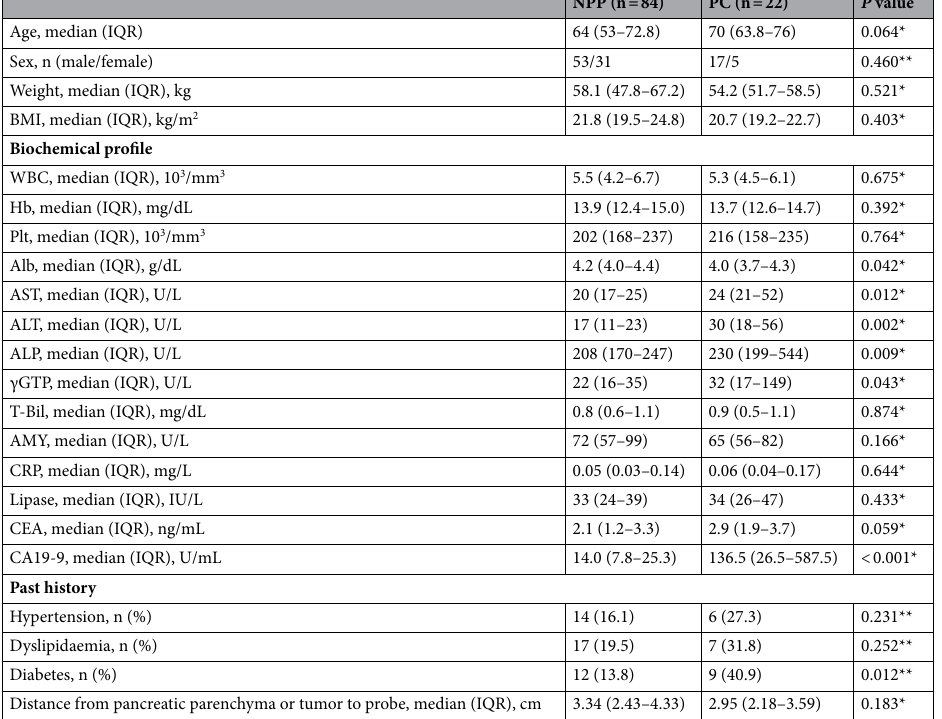
Table 3. Characteristics of the study population. NPP normal pancreatic parenchyma, PC pancreatic cancer, IQR interquartile range, BMI body mass index, WBC white blood cell, Hb hemoglobin, Plt platelet, Alb